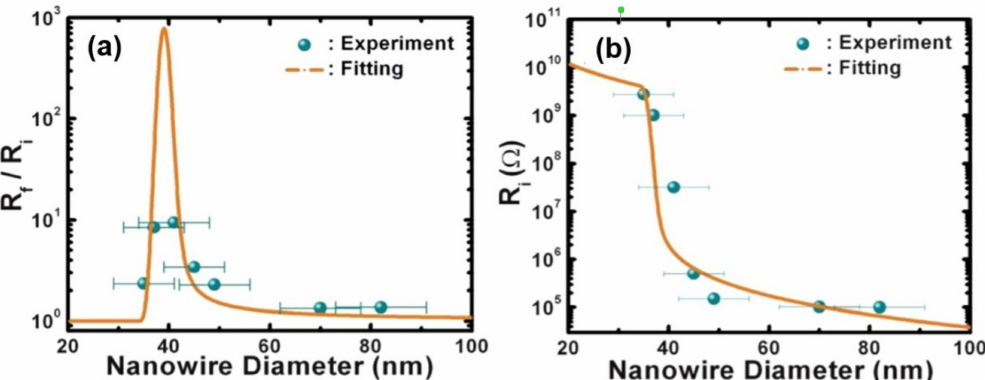
Figure 30. Influence of fiber diameter ( a ) on the response of WO 3 NF-based sensor to 150 ppb NO gas, and ( b ) on the initial resistances of the sensors. Reprinted with permission from [27]. Copyright 2012